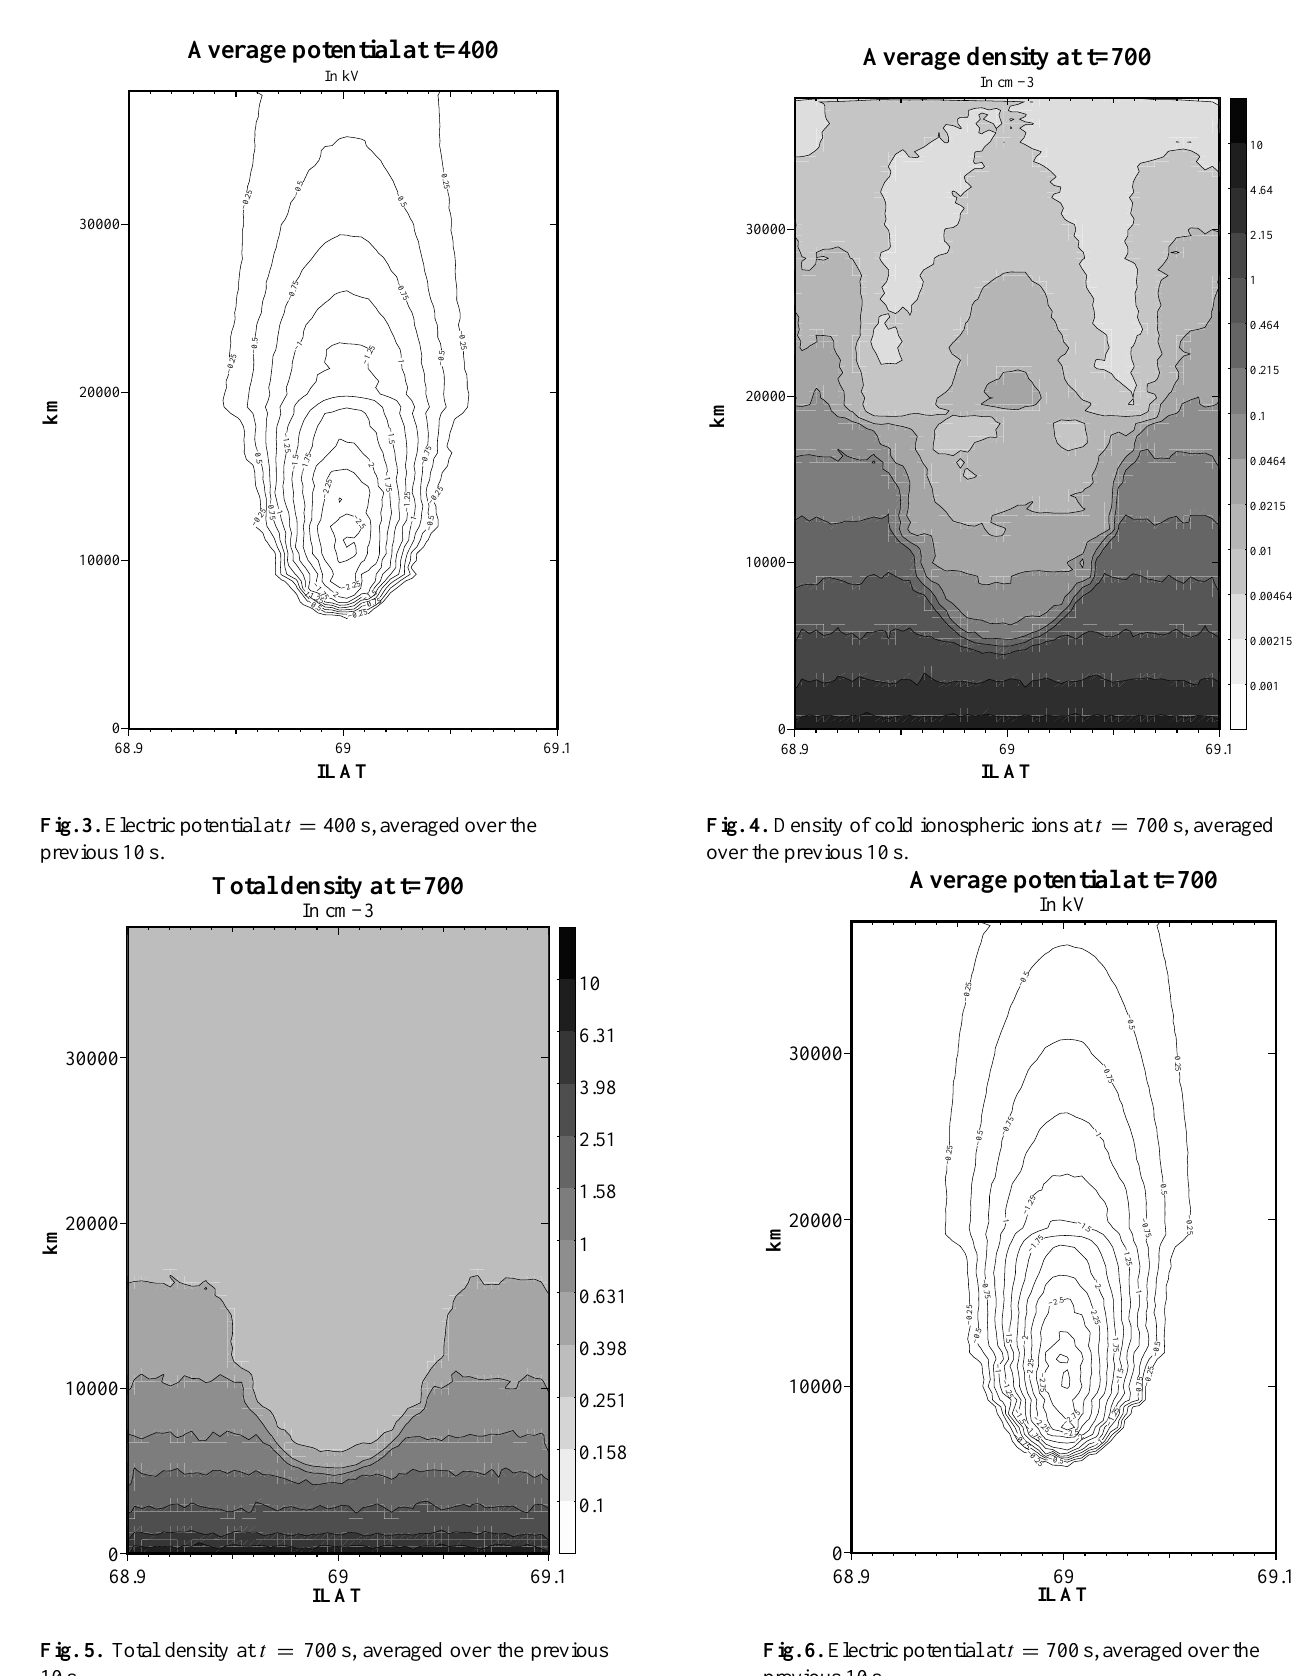
Fig. 5. Total density at t = 700s, averaged over the previous 10s.